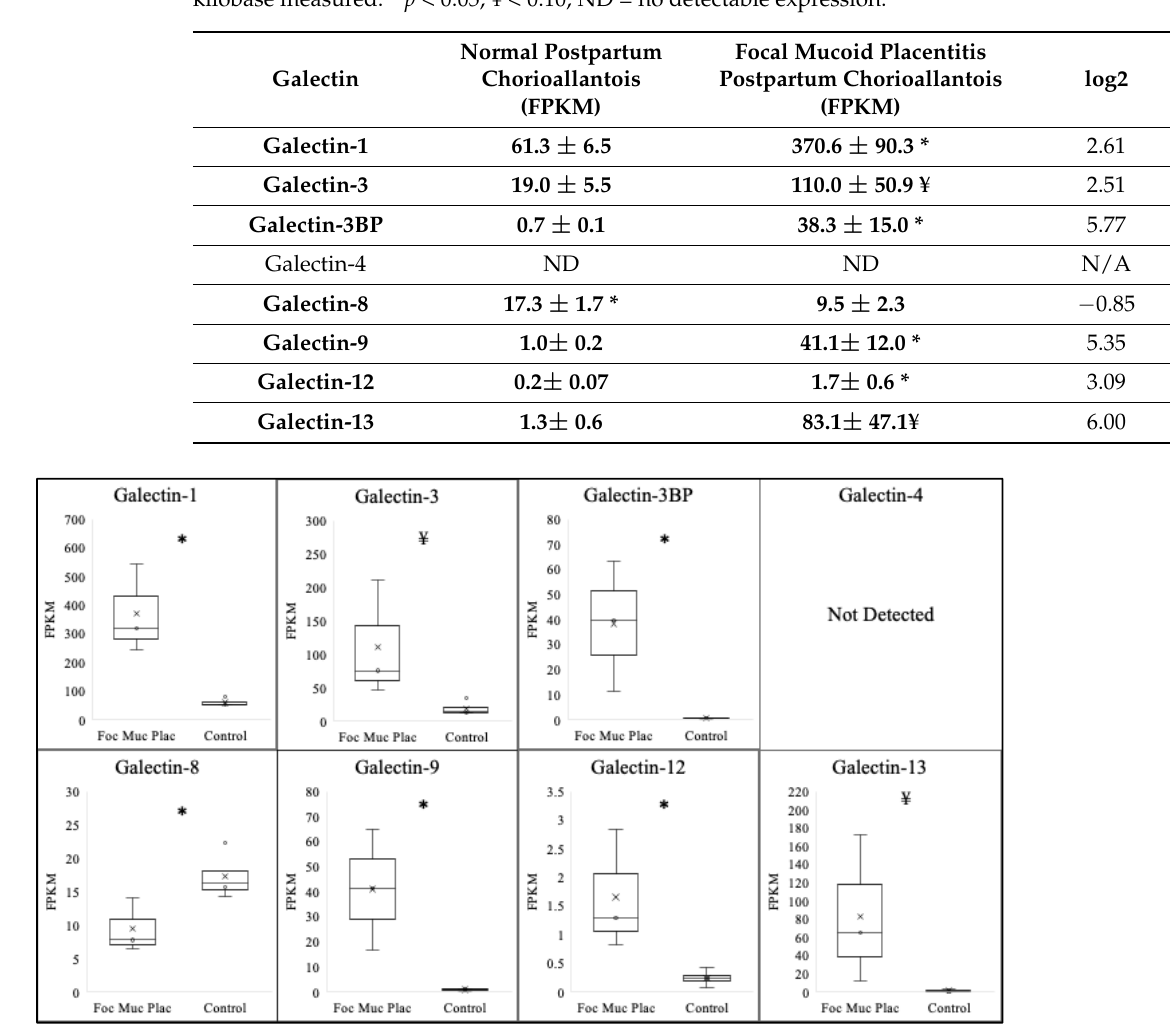
Figure 2. Expression profile of various galectins following focal mucoid placentitis. Expressions of galectin-1, galectin-3BP, galectin-9, and galectin-12 increased ( p < 0.05) following focal mucoid pla- centitis in postpartum chorioallantois, while expressions of galectin-3 and galectin-13 experienced a trend toward an increase ( p < 0.10). Expression of galectin-8 decreased following focal mucoid placentitis. Expression of galectin-4 was not above the FPKM threshold for detection. * p < 0.05. ¥ < 0.10. Table 2. Expression of various galectins following focal mucoid placentitis. FPKM = fragments per kilobase measured. * p < 0.05, ¥ < 0.10, ND = no detectable expression.